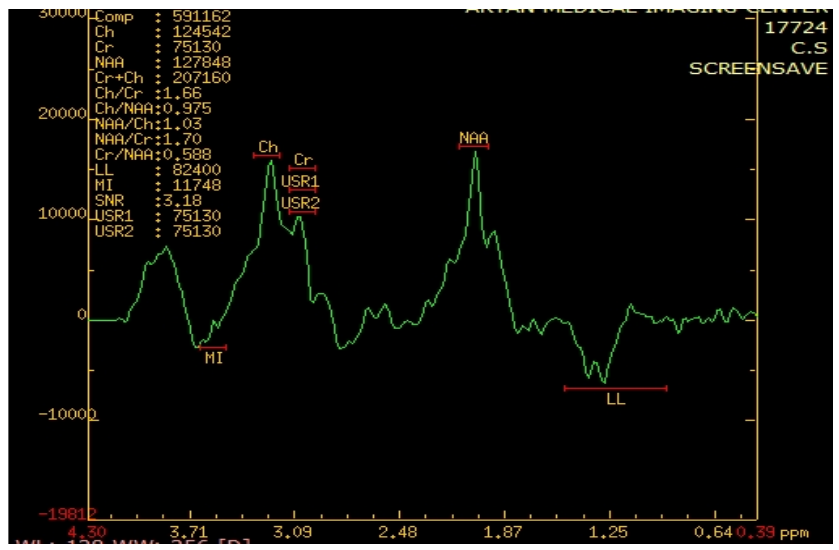
Fig. 3. MRS: inverted doublet lactate peak indicating elevated lactate level in the brain